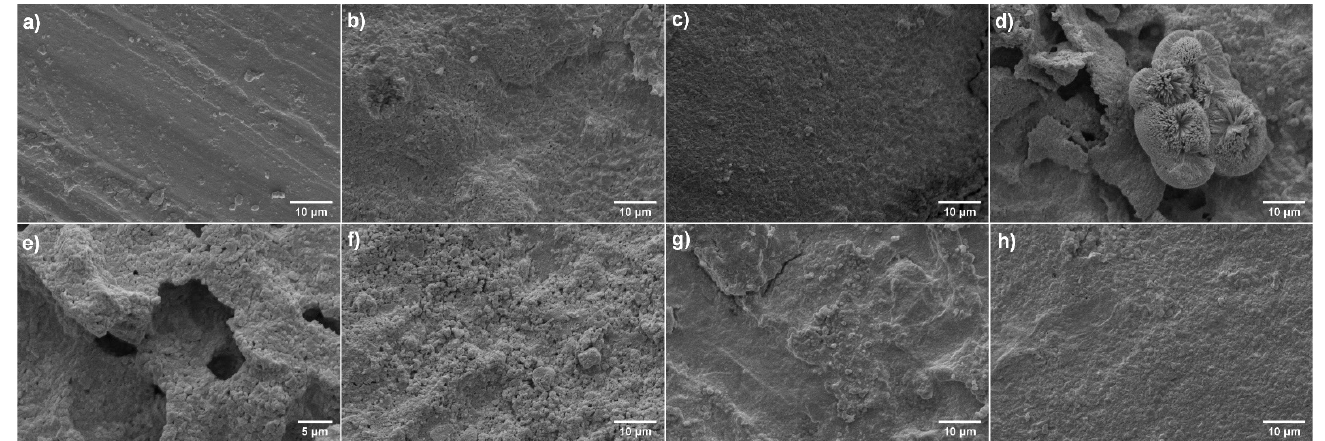
Figure 4. SEM images (magnification 1500×) of Freedom samples: ( a ) control, ( b ) H 2 O, ( c ) NaCl, ( d ) AS pH 4.5, ( e ) AS pH 4.5 (magnification 2500×), ( f ) AS pH 5.5, ( g ) AS pH 7.0, ( h ) AS pH 7.5.